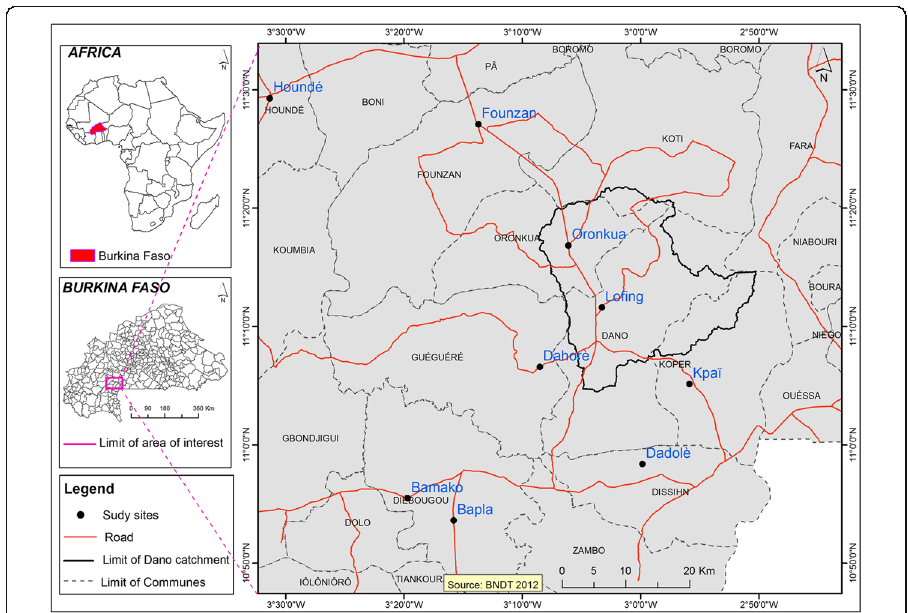
Fig. 1 Sampled communities in Southwestern Burkina